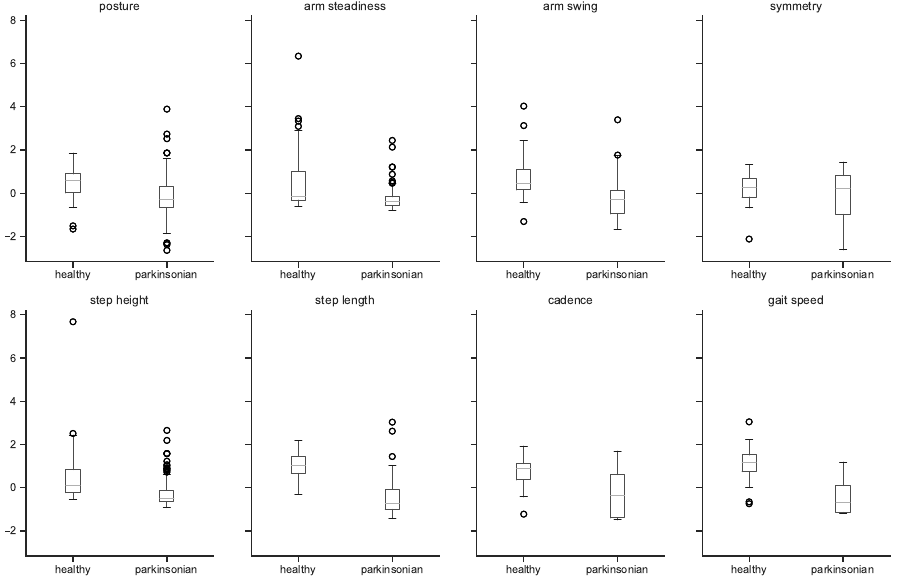
Figure A1. Features analysis by class (side view).